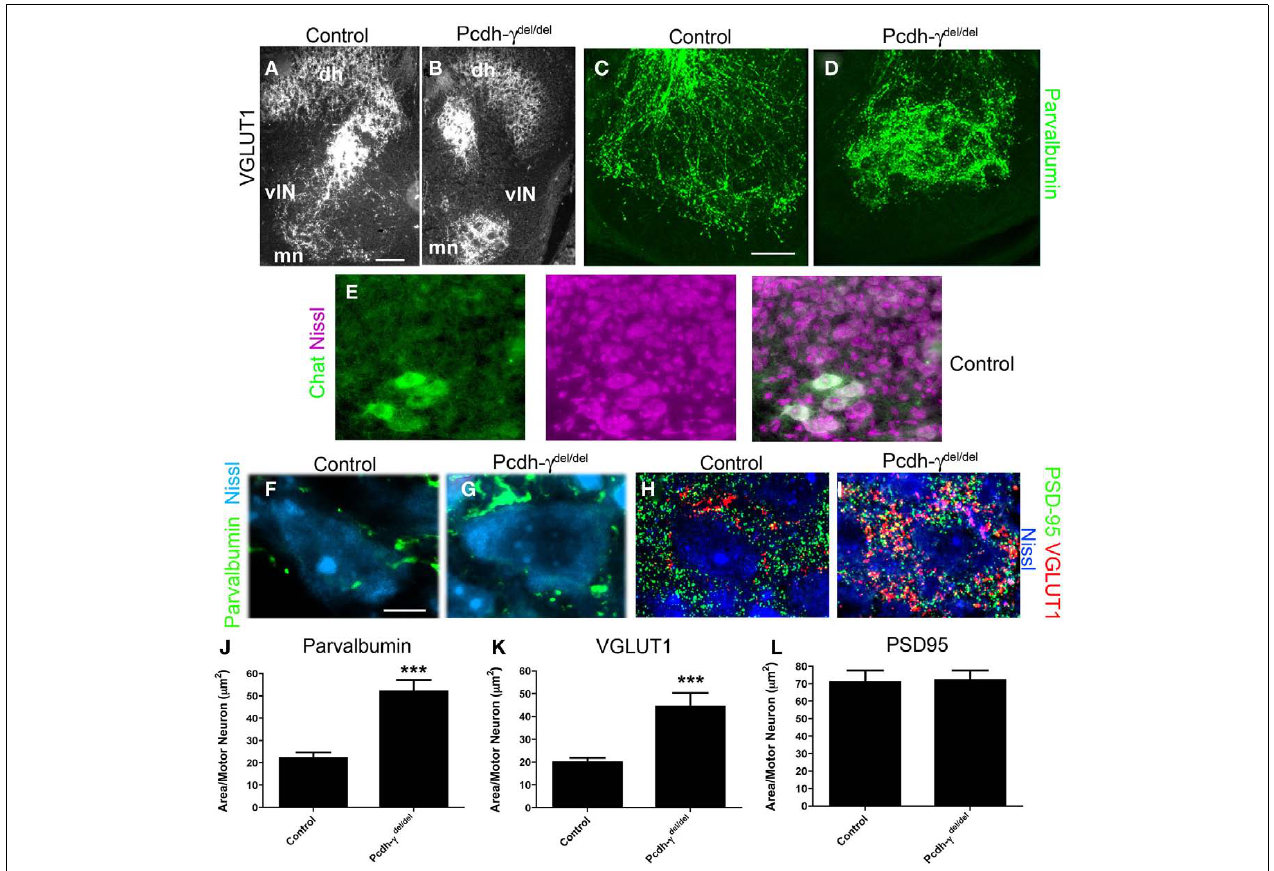
FIGURE 4 | Ia afferent terminals on motor neurons are significantly increased in area in Pcdh- γ null mutants. (A,B) P0 control and Pcdh- γ del/del spinal cord immunostained with antibodies againstVGLUT1 shows clumping of terminals around motor neurons (mn) with a corresponding reduction of collateral terminals (lateral to motor neurons) on ventral interneurons (vIN), similar to the parvalbumin staining in Figure 3 , and at higher magnification in (C,D) . (E) Motor neurons can be reliably identified by their distinctive Nissl staining profile, as confirmed by double staining with antibodies against ChAT. (F–H) High magnification views of P0 control and Pcdh- γ del/del spinal cord in the